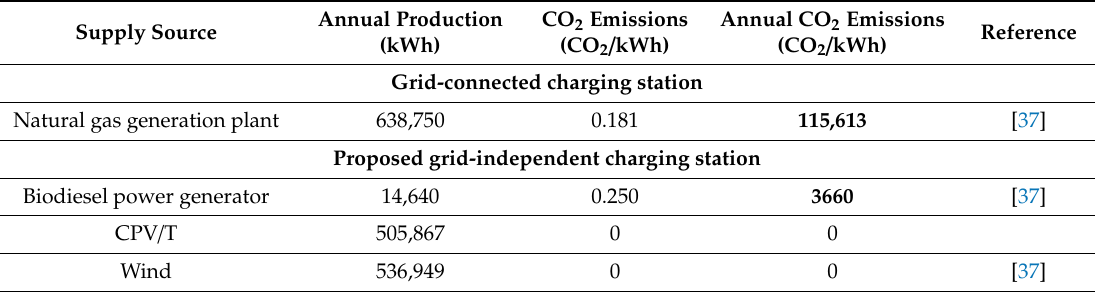
Table7. Grid-connectedvs. RES-based,grid-independentchargingstationCO 2 emissionsduringoperation.